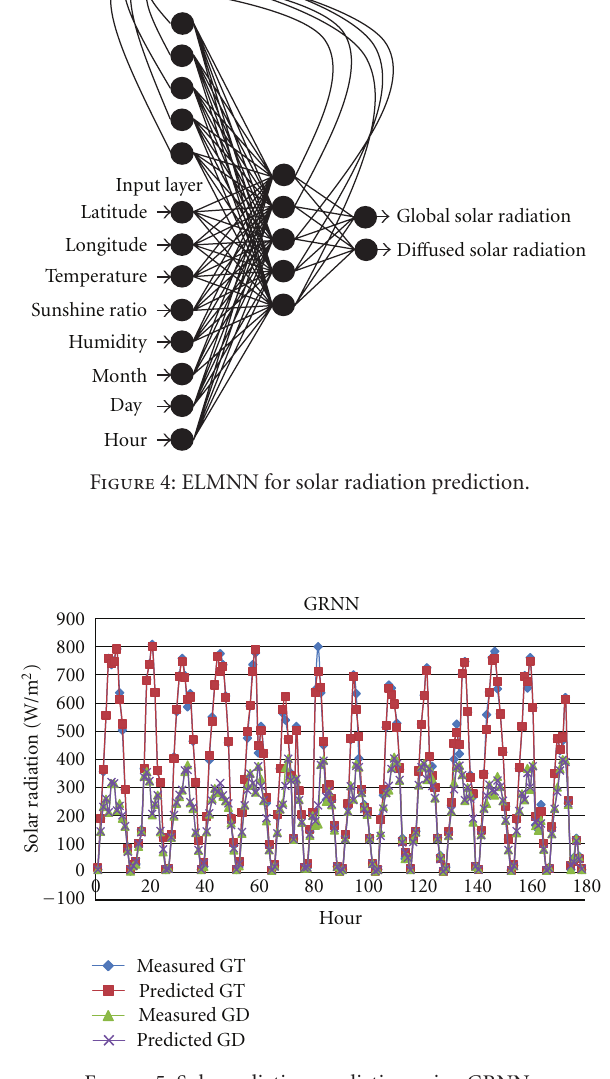
Figure 5: Solar radiation prediction using